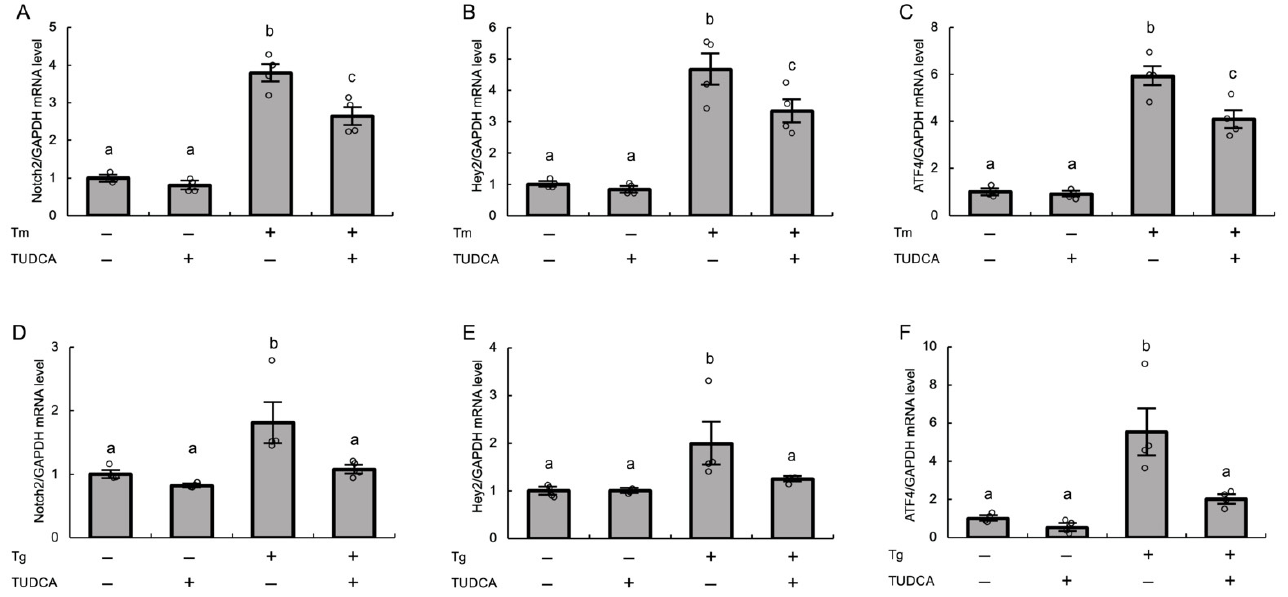
Figure 3. Effects of ER stress on Notch2 signaling in cultured human GLCs. After preincubation with TUDCA (1 mg/mL) for 24 h, human GLCs were treated with ( A – C ) tunicamycin (2.5 µg/mL) for 24 h or ( D – F ) thapsigargin (1 µM) for 6 h. The expression levels of ( A , D ) Notch2, ( B , E ) Hey2, and ( C , F ) ATF4 mRNAs were measured by real-time PCR and normalized to that of GAPDH. Values represent means ± SEM, relative to the mean control value. The letters denote significant differences between groups. Tm, tunicamycin; Tg, thapsigargin.